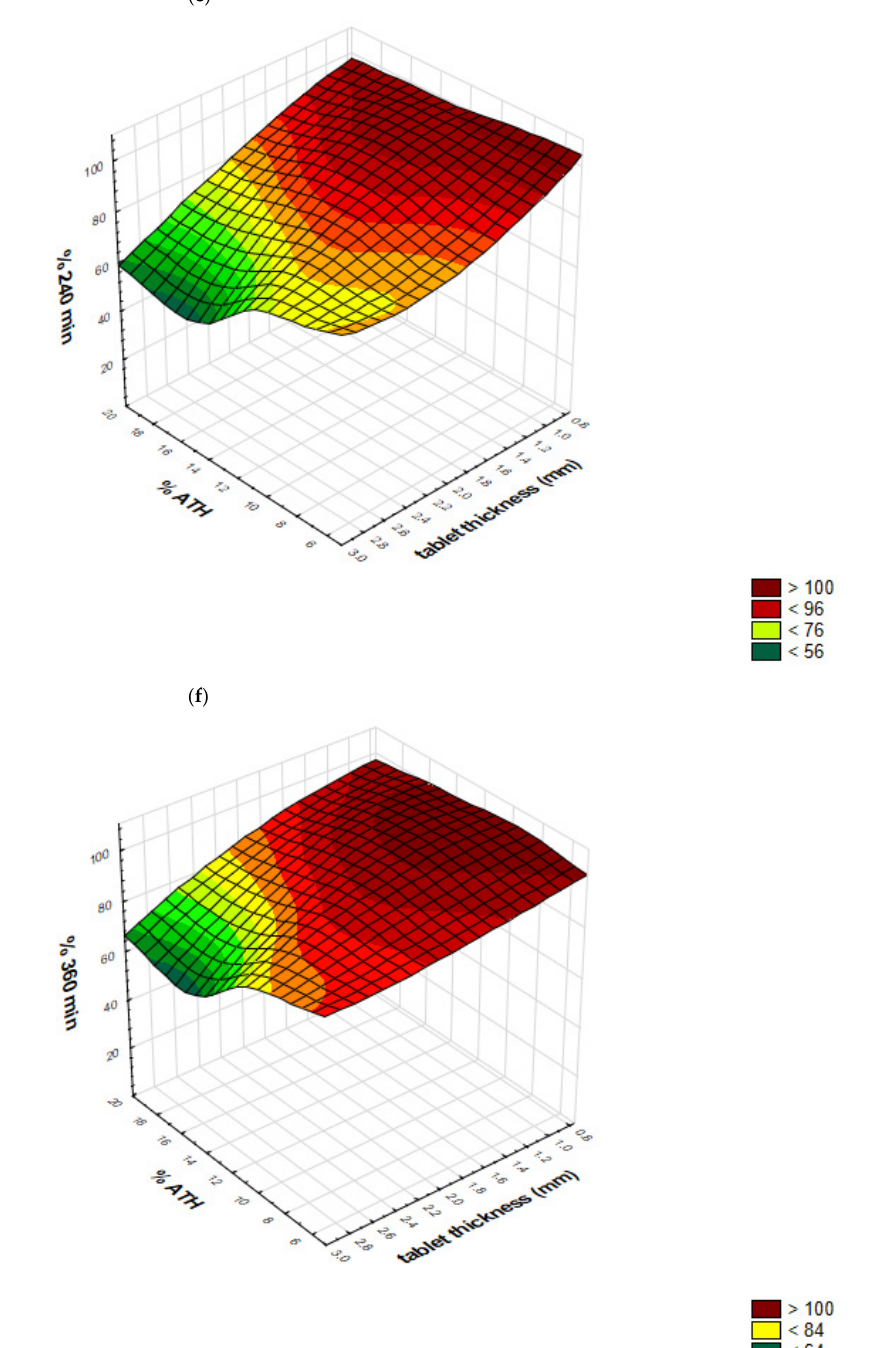
Figure 12. Response surfaces, representing outputs (Y1–Y6 percent of drug released after prede- termined time intervals) as a function of drug loading (% ATH) and tablet thickness: ( a ) Y1—after 15 minutes; ( b ) Y2—after 30 minutes; ( c ) Y3—after 60 minutes; ( d ) Y4—after 120 minutes; ( e ) Y5—after 240 minutes; ( f ) Y6—after 360